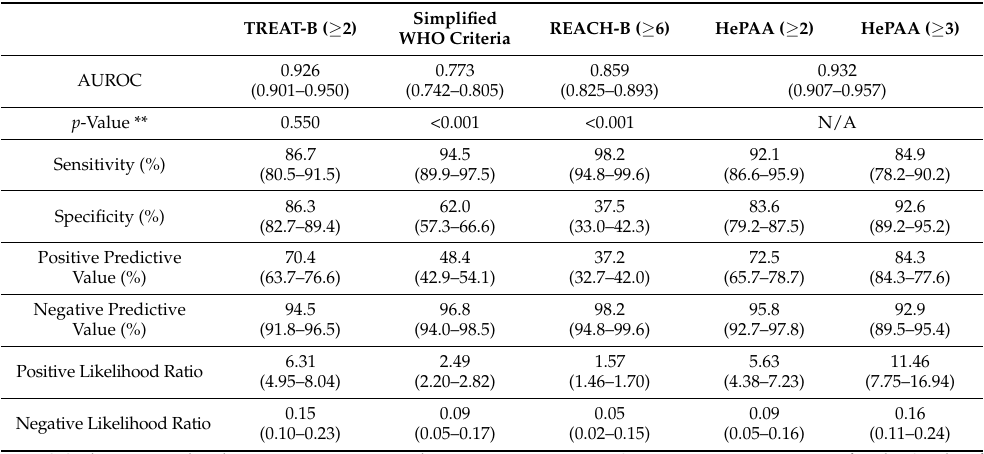
Table 4. The performance of various systems in determining chronic hepatitis B treatment eligibility, according to EASL guidelines, in the derivation cohort ( n =